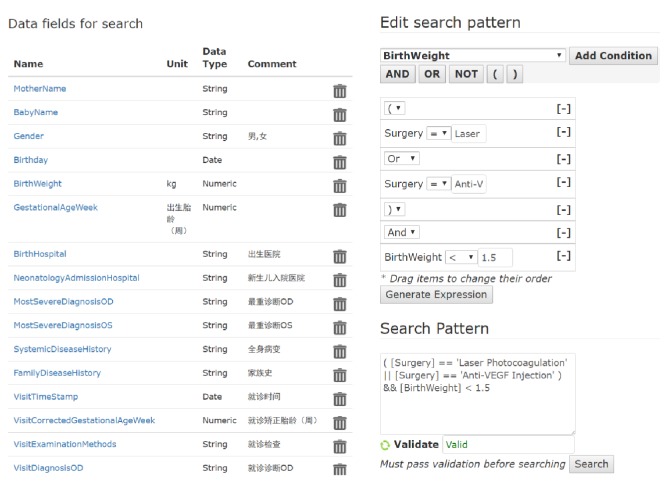
SDE for authoring CT recruitment criteria. The left panel is a list of data fields that can be used as rule variables in the search patterns. These data fields come from the database schema of the central data repository. The right panel is a graphical rule editor. It supports conditional predicates (composed of rule variables and comparison operators, e.g., [BirthWeight] <= 1.5), logical operators (AND, OR, and NOT), and parentheses (specify precedence). For each rule variable, the available comparison operators are strictly confined based on its data type. If the variable is numeric or date type, allowed comparison operators will be “>=, <=, >, <, =, !=”. If the variable is string type, the allowed comparison operator will be “=,” and the rhs (right-hand side) constant can be a string literal with wild cards (“%”). The sequence of rule components can be adjusted by drag and drop. Furthermore, the graphical editor can generate a rule expression into the textual editor. The textual editor also allows the user to directly edit rule expression with autocomplete (IntelliSense) utilities.